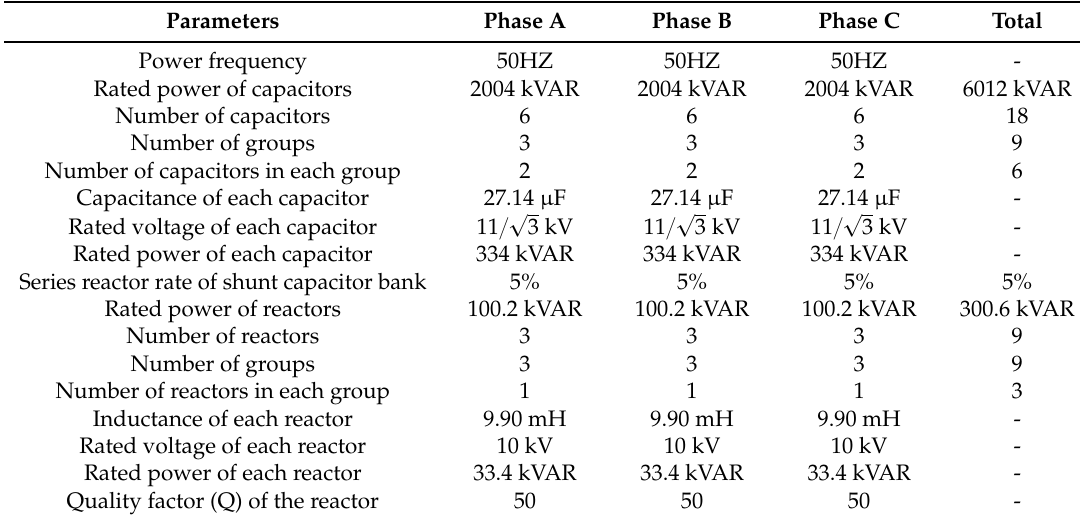
Table 2. Typical cases of switching 10 kV shunt capacitor banks